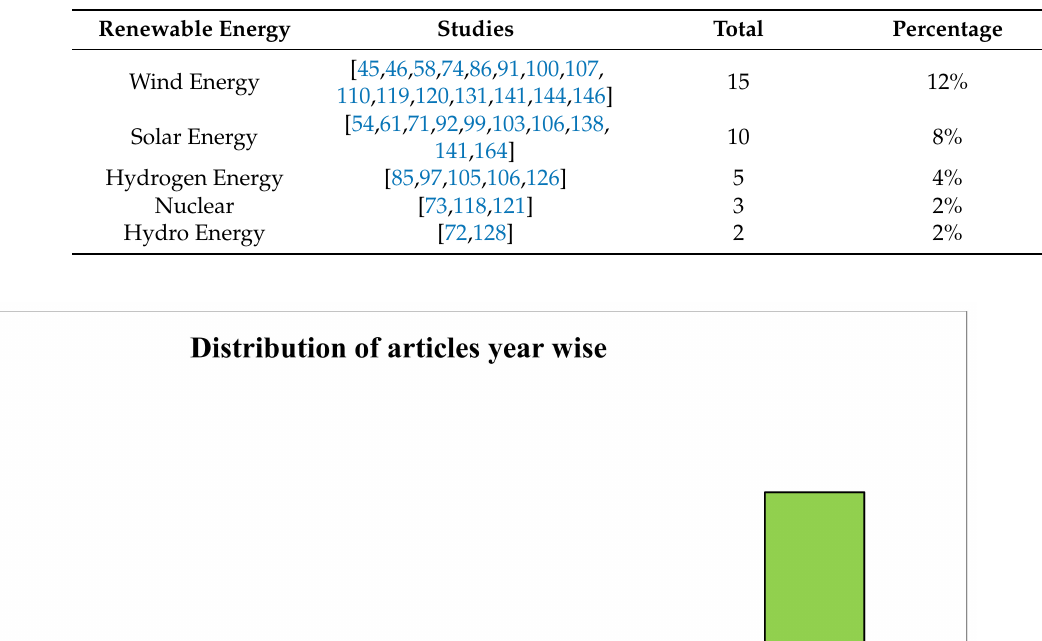
Table 9. Distribution of studies based on the prominent renewable energy source.